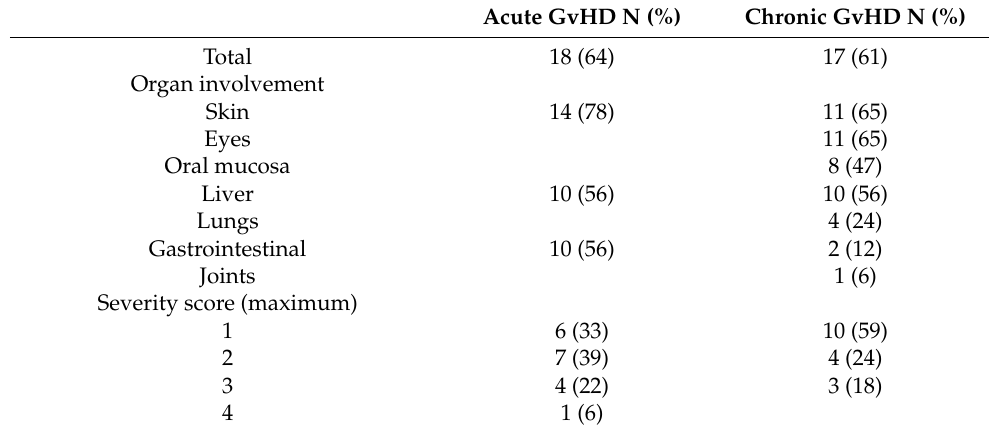
Table 2. Characteristics of acute and chronic graft-versus-host disease (GvHD) in allogeneic patients ( n =